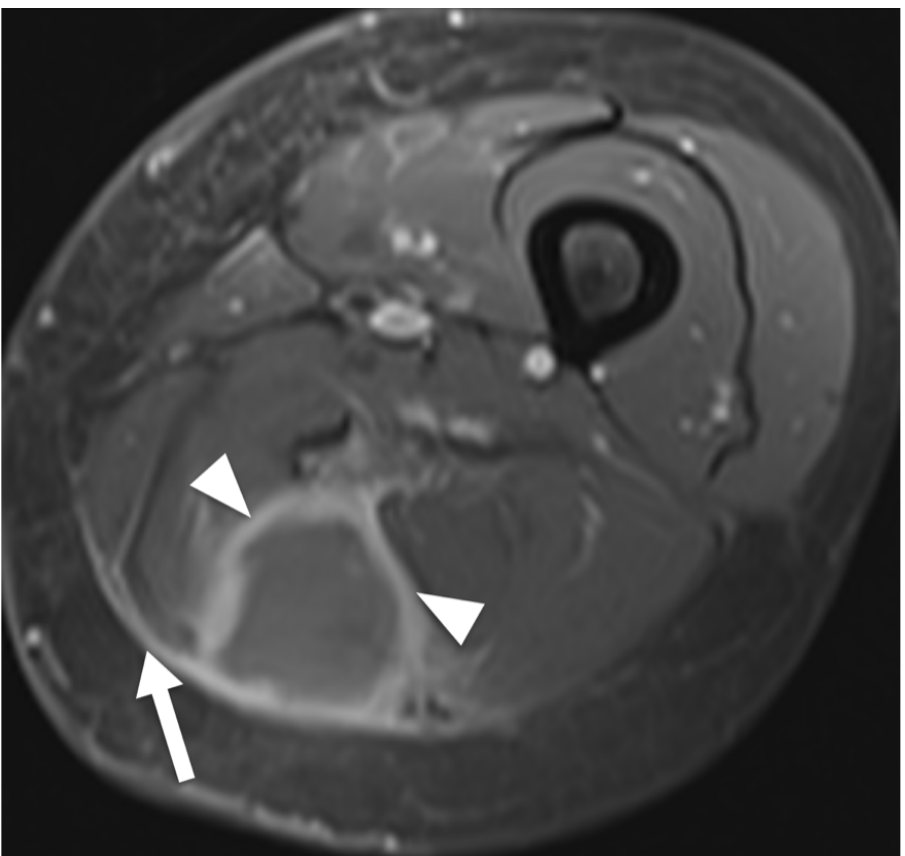
Figure 3. MRI of a 68-year-old woman presenting with non-Hodgkin lymphoma manifestation in the thigh. Transversal contrast enhanced fat-saturated T1-weighted image shows a tumor in the posterior compartment of the thigh, revealing predominant enhancement of tumor margins (arrowheads). Moreover, signal alteration of fascia lata can be noted (arrow).